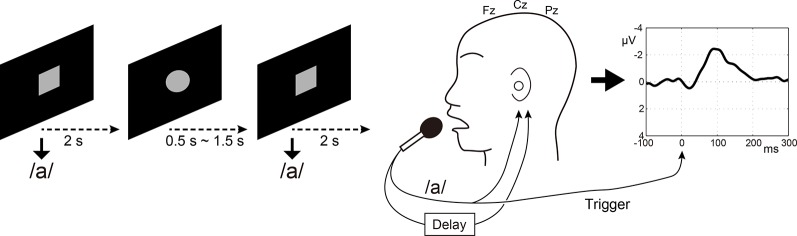
Speaking condition in the electroencephalography (EEG) experiment. Participants were instructed to vocalize /a/ very lightly soon after that a gray circle drawn on a black background changed to a gray square. Three midline electrodes Fz, Cz, and Pz were used for calculating auditory evoked potential in response to auditory feedback of speech. The speech signal was sent into an auxiliary EEG channel for offline-extraction of the onsets of individual speech.